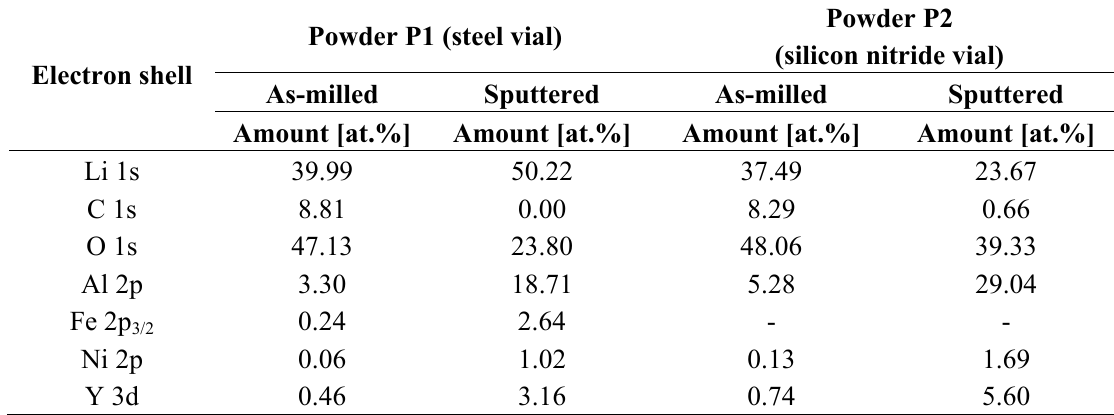
Table 2. Atomic concentration table of the XPS